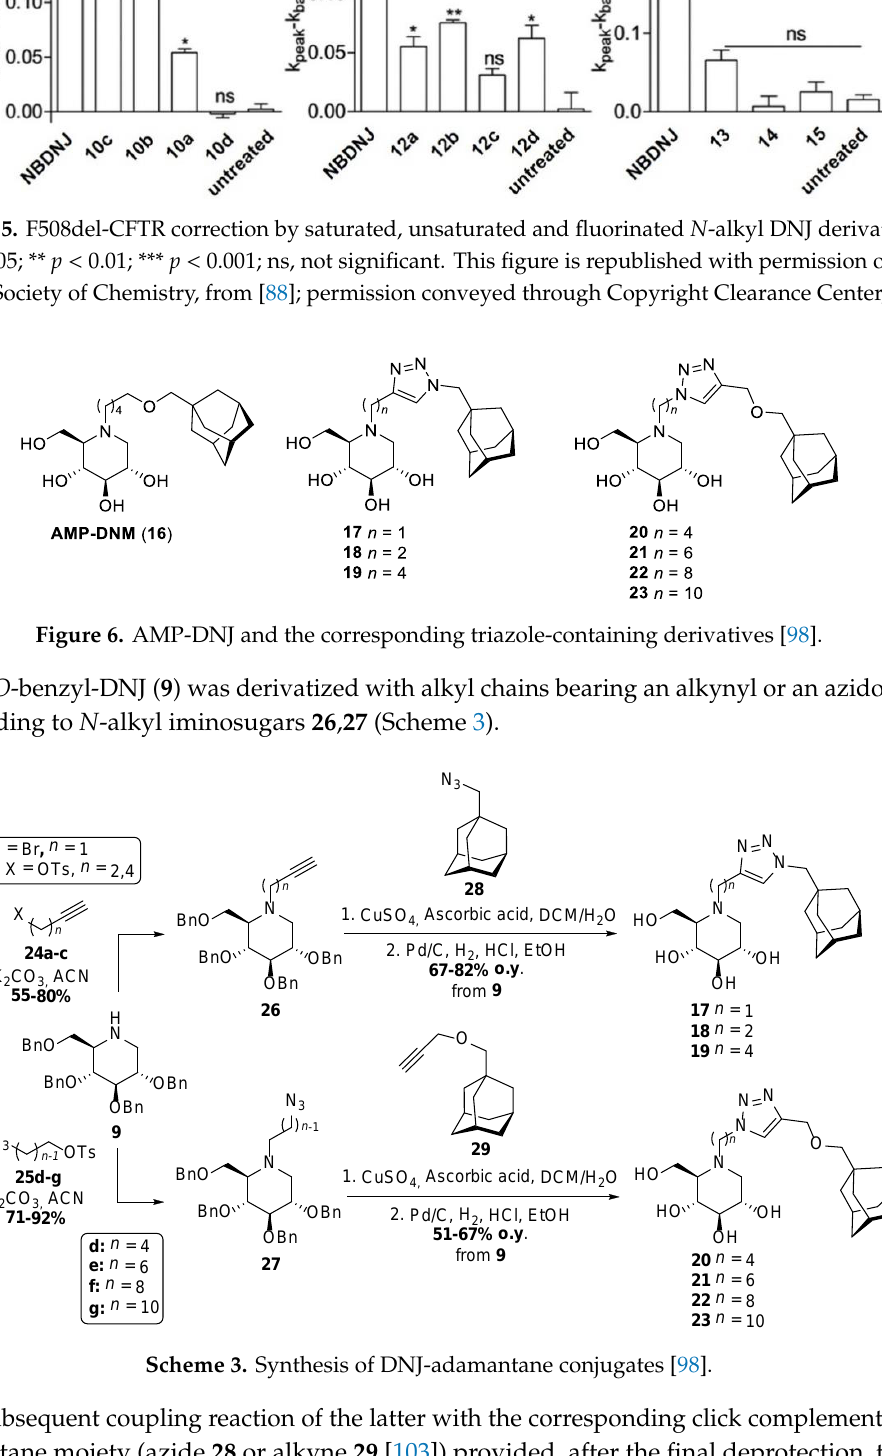
Figure 5. F508del-CFTR correction by saturated, unsaturated and fluorinated N -alkyl DNJ